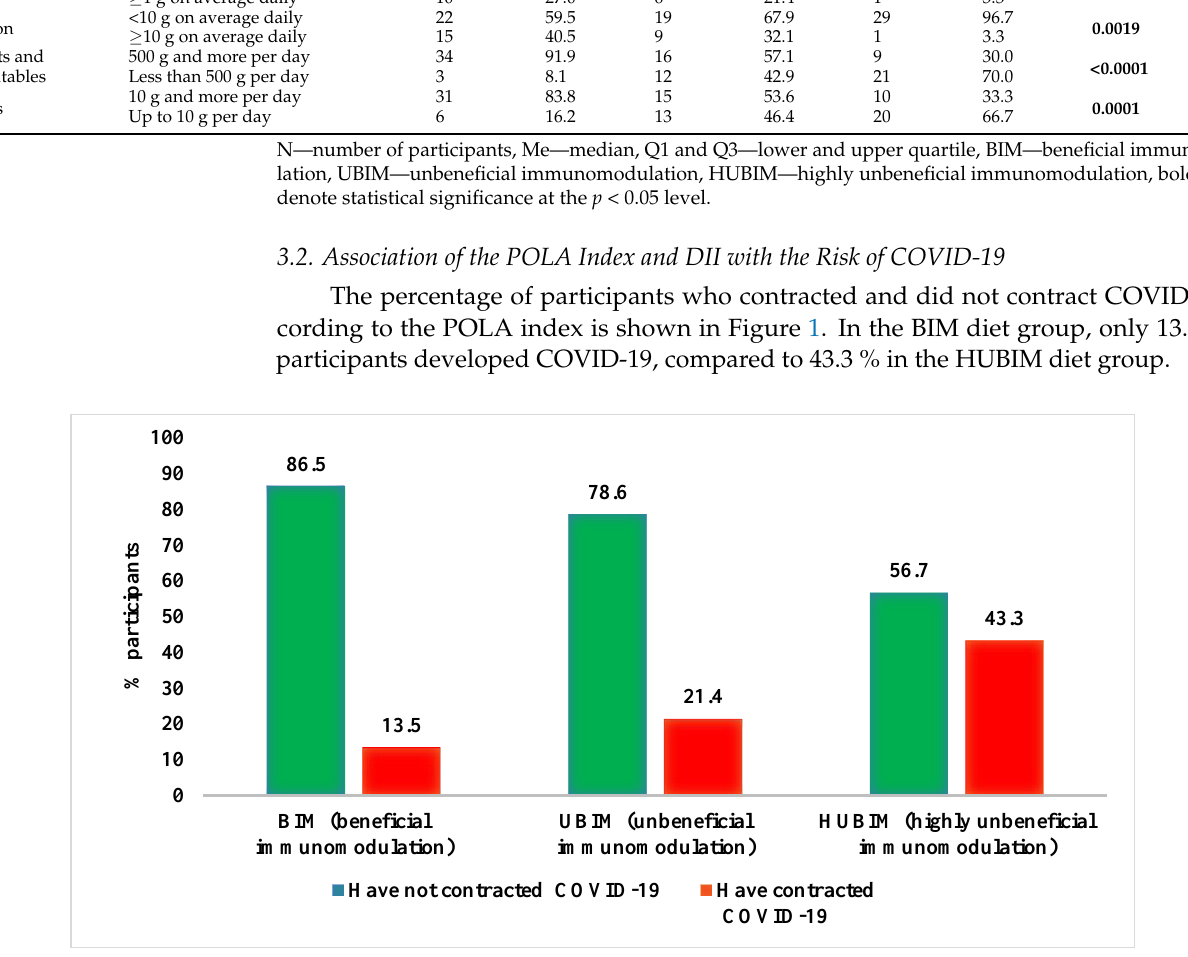
Figure 2. Incidence of COVID-19 in relation to the DII. The risk of COVID-19 according to the categories of the DII and POLA index is shown in Table 5. Participants in the third DII tertile showed almost four-fold greater odds of COVID-19 in a crude model, compared with participants in the lowest DII tertile. How- ever, the difference was no longer significant after adjustment for the type of diet, sex, marital status, age, body fat percentage, smoking, and the presence of Escherichia coli . Based on the POLA index, the BIM diet group showed about 80% lower odds of COVID- 19 than the HUBIM diet group. The result remained significant regardless of the level of adjustment (OR = 5.29, 95%CI: 1.43 – 22.55 for HUBIM vs. BIM in the fully adjusted model).